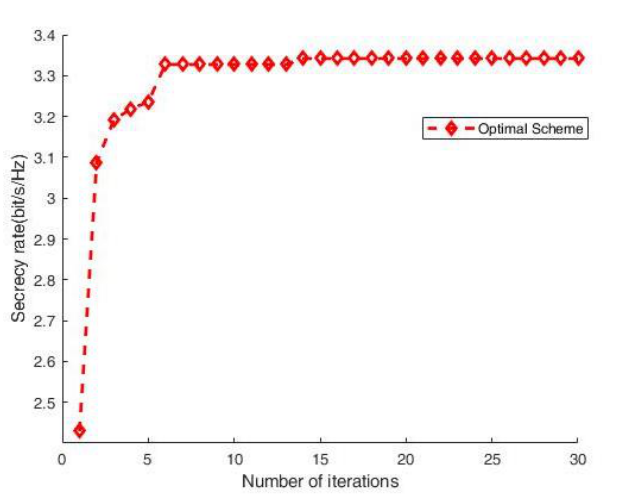
Figure 3. Secrecy rate vs.